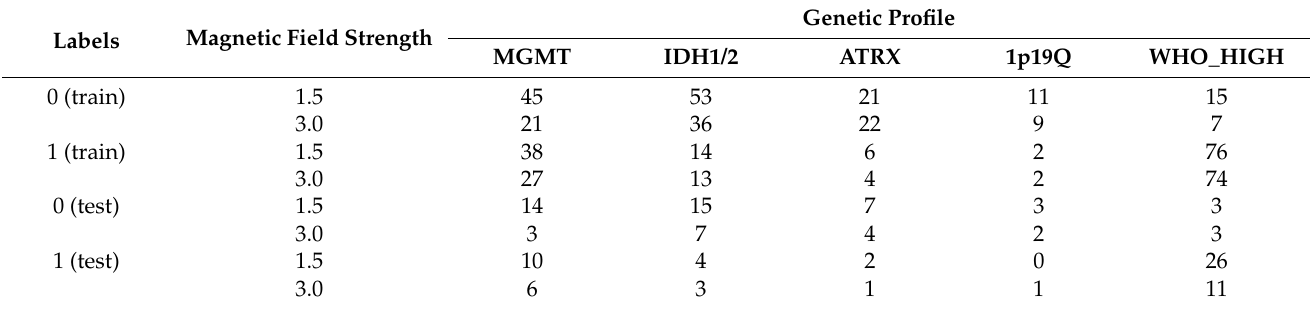
Table 3. Distribution of the train and test among magnetic field